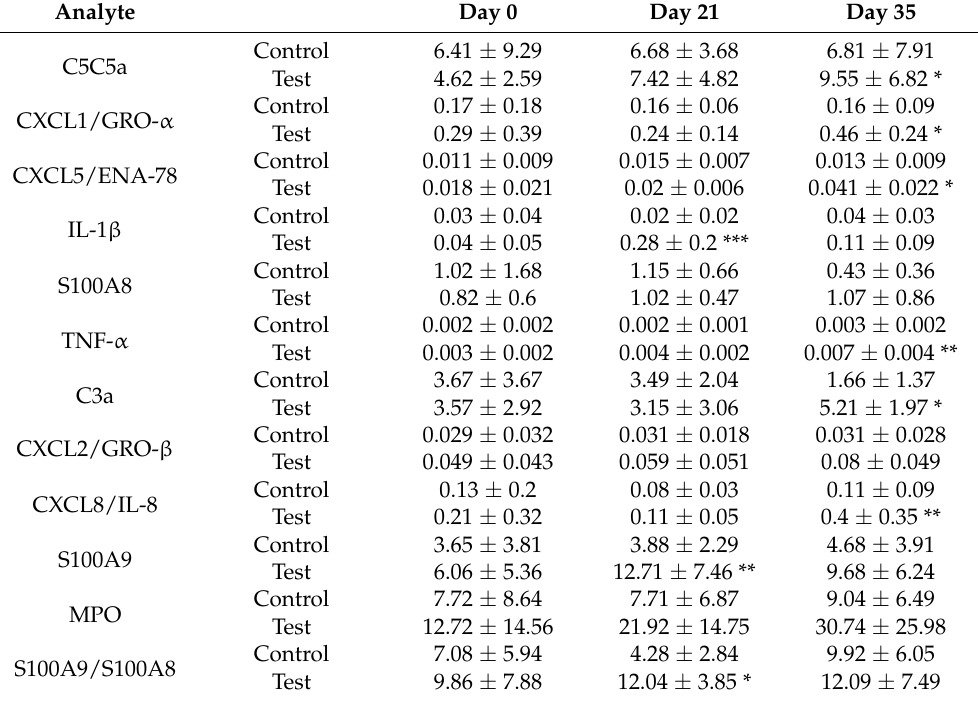
Table 2. Cytokine quantification from GCF samples. Collected and processed GCF samples from control and test sites for days 0, 21 and 35 were measured for levels of pro-inflammatory host mediators. GCF volumes were normalised according to the amount of protein quantified and data are expressed as amount (pg) per 30 s sample time as previously described (Chapple et al., 1996 [17]). Data are presented as mean ± standard deviation. Statistical test: one-way ANOVA and